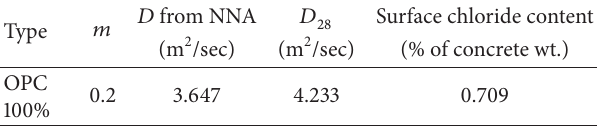
Table 9: Analysis condition for verification (field